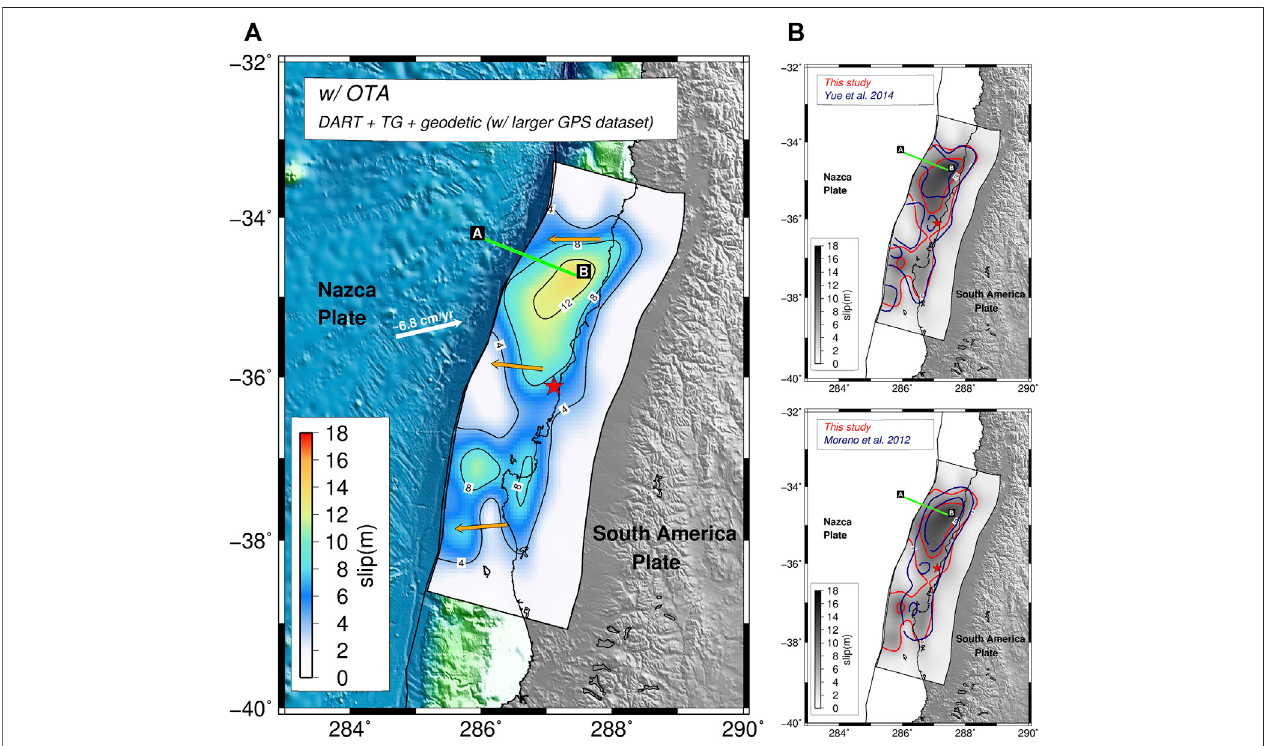
FIGURE11|(A) Rupturemodelofthe2010Mauleearthquakeestimatedbyjointlyinvertinggeodetic,DART,tide-gaugedata,andapplyingOTA;theGPSdataset usedinthiscaseislargerthantheoneshownin Figure9 andisthesameusedfrom(Morenoetal.,2012)and(Yueetal.,2014).Solidblacklinesshowstheslipcontourat 4 minterval;redstarrepresentstheepicenteroftheMauleearthquake;orangearrowsrepresenttheaverageslipdirections(rake);greenlinerepresentstheILOCAtrack. The fi gure also shows the comparison between the 5 m slip contour lines from the model (red line) presented in panel (A) and the model (blue line) by (B) Yue et al. (2014) and (C) Moreno et al.